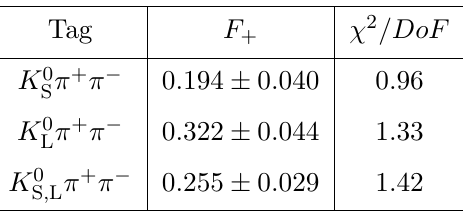
(cid:25) + (cid:25) (cid:0) (cid:25) 0 from the tags K 0 S